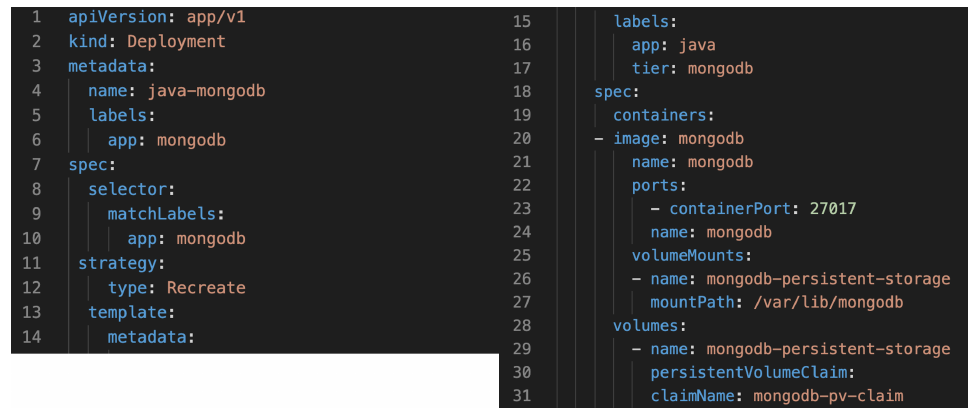
Figure 9. Kubernetes